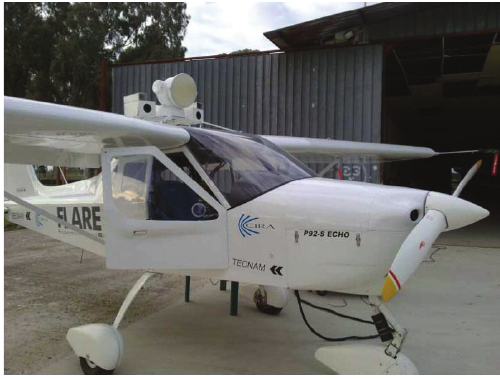
Figure 2: Sensing system onboard FLARE.